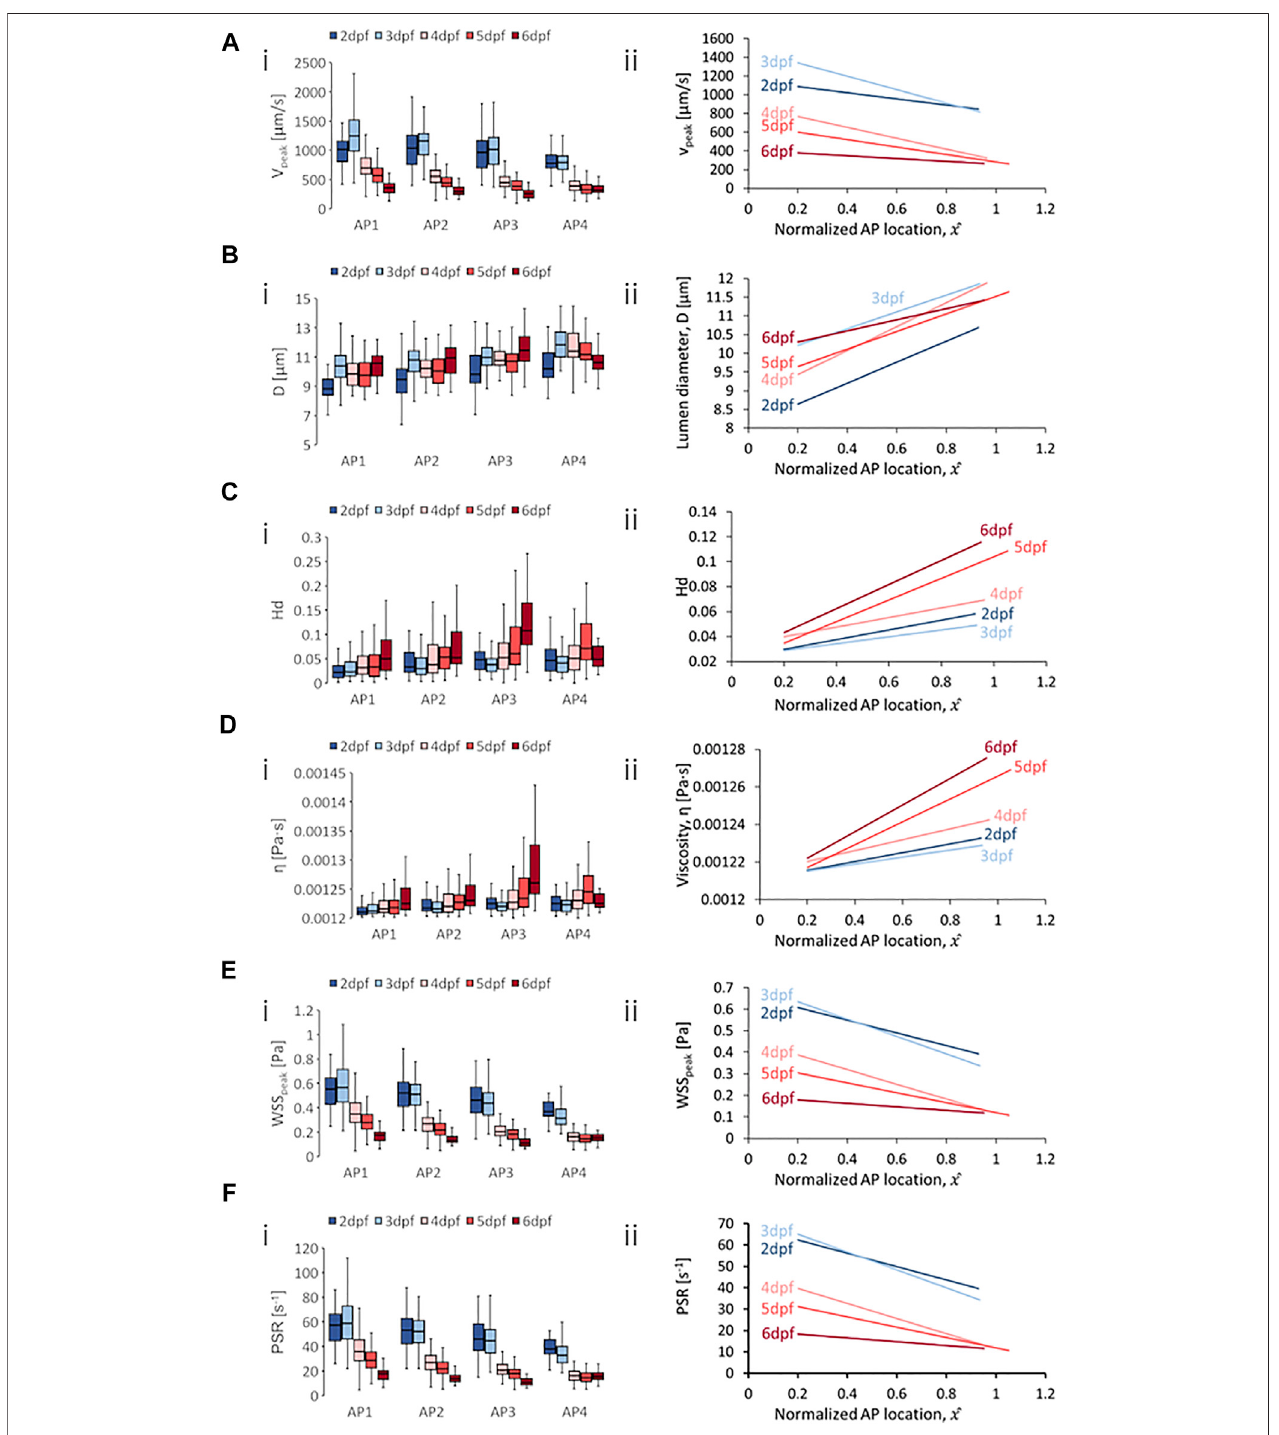
FIGURE 6 | Developmental trends of morphological and hemodynamic quantities in the arterial intersegmental vessels (aISVs). (A) The changes in V peak at four regionsalongtheanterior-to-posterior(AP)axis (i) andtheAPtrendfor V peak (ii) . (B) Thechangesin D atfourAPregions (i) andtheAPtrendfor D (ii) . (C) Thechangesin H d atfourAPregions (i) andtheAPtrendfor H d (ii) . (D) Thechangesin η atfourAPregions (i) andtheAPtrendfor η (ii) . (E) Thechangesin WSS peak atfourAPregions (i) and the AP trend for WSS peak (ii) . (F) The changes in PSR at four AP regions (i) and the AP trend for PSR (ii) . Box plots in (i) of Panels (A – D) show the median and the fi rst (Q1) and third (Q3) quartile levels of the hemodynamic quantity for the pooled zebra fi sh data. The whisker bars represent the maximum and minimum ranges of the data that lie within 1.5 times of the interquartile range (IQR = Q3 − Q1) beyond Q1 and Q3.